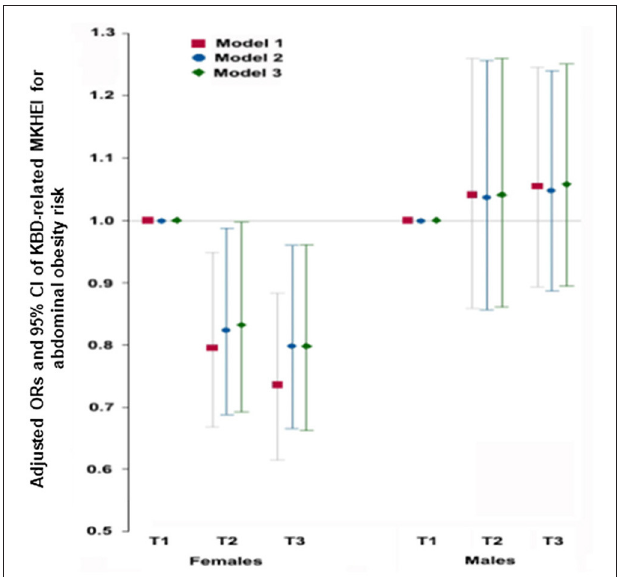
FIGURE 3 | Adjusted odds ratios (95% CI) for obesity calculated by waist circumference after adjustments for covariates according to Western-style diet scores. Western-style diet scores were calculated by summing meat & eggs intake, noodle intake, percentage of energy from saturated fatty acids and fast foods. Model 1; adjusted for age and residence region. Model 2; adjusted for the covariates of model 1 + education, income, and marital status. Model 3: adjusted for the covariates of model 2 + smoking, alcohol, regular